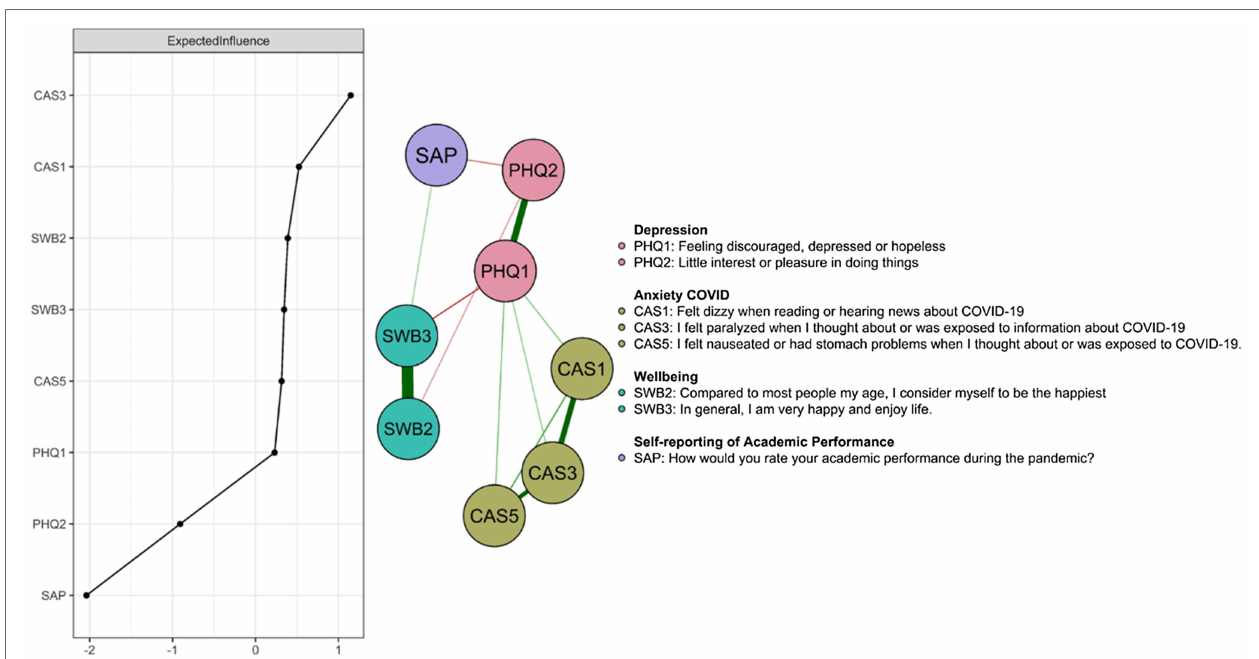
FIGURE 1 | Depression, COVID-19 anxiety, well-being, and academic performance in university students with COVID-19-infected relatives. The EIs are shown in the left panel. The phrasing of the coronavirus anxiety scale items was shortened in order to enter them in the Figure; for complete information on the items, see Caycho-Rodríguez et al.